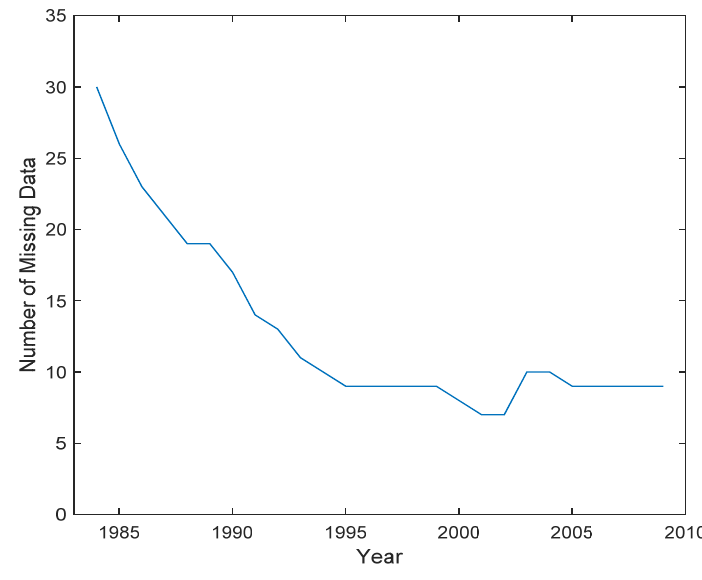
Figure 4. The number of missing records from 1984 to 2009.